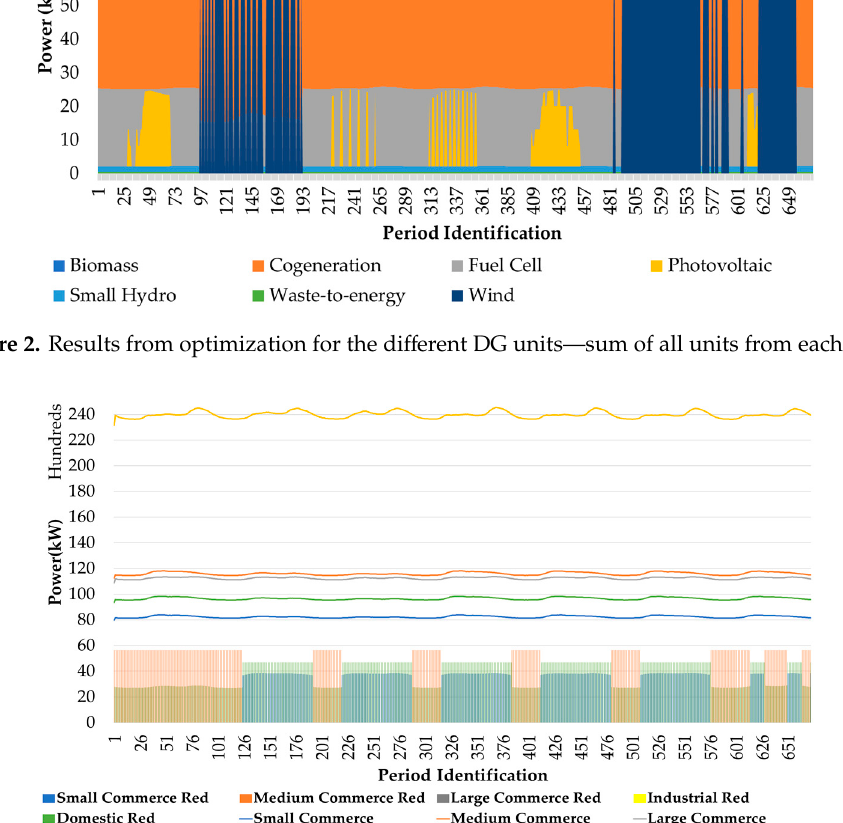
Figure 3. Results from optimization for the different types of consumers—sum of all consumers from each type (in red) and the initial load for comparison.